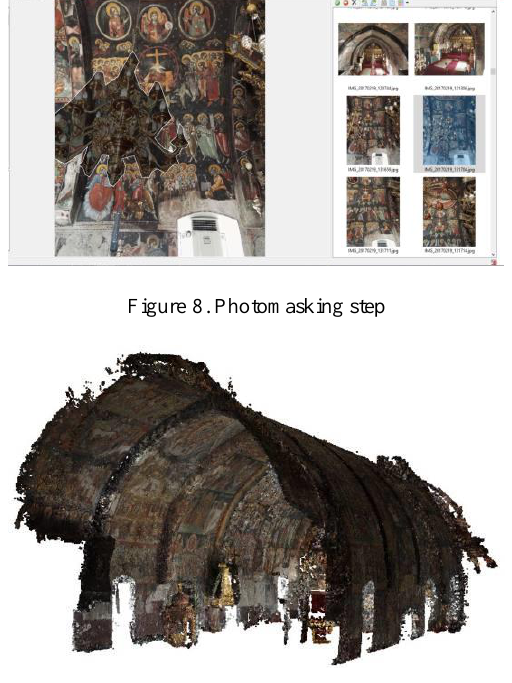
Figure 9. Dense cloud reconstruction of the barrel vault